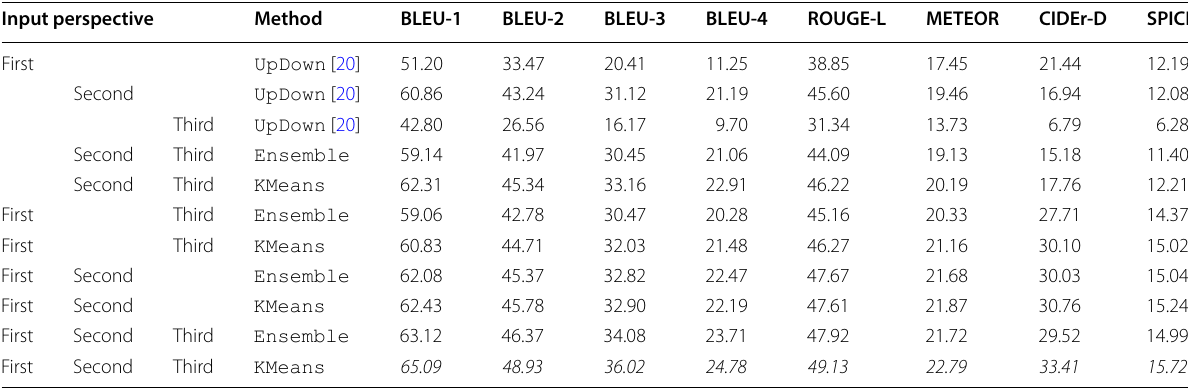
Table 1 Ablation study of image captioning performance on our dataset